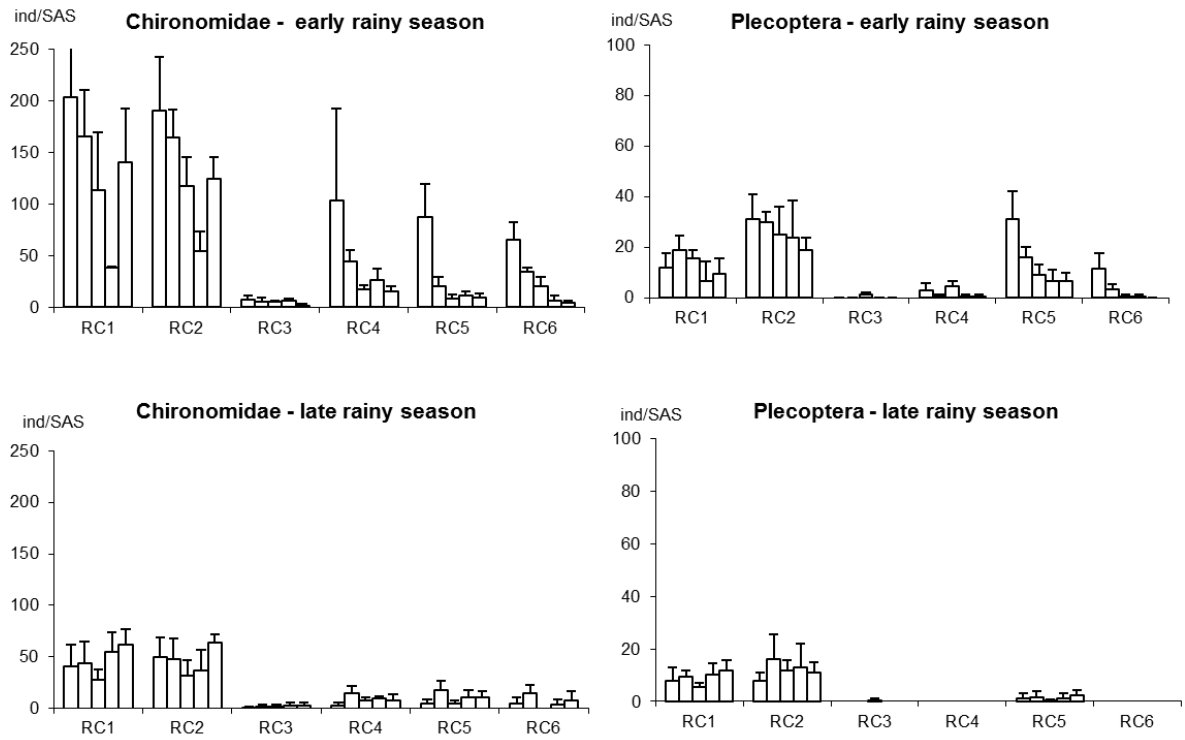
Figure 4. Accumulating effects on the abundance aquatic insects (Chironomidae and Plecoptera, individuals per standardised artificial substrate, averages plus standard deviation) from the beginning (22 October 1994–16 December 1994) to the late (8 March 1995–3 May 1995) rainy season (Each pillar represents a 14 day interval) in a Cerrado stream. RC1, RC2: reference sites above the confluence with the erosion gully (RC3), RC4-RC6: impact sites with growing distance below the confluence. Data from Karl M. Wantzen [29], see [14,49] for site and method